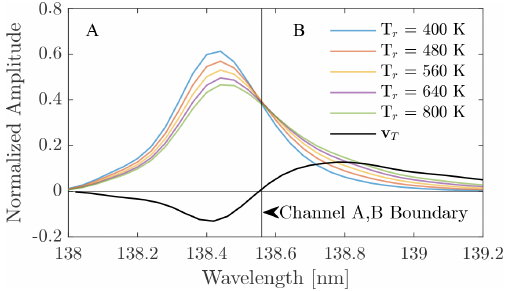
Figure 1. Simulated top-of-atmosphere mean LBH emissions s (gray), I LBH , and the principal components associated with over- all brightening of emissions (dashed black), v B , and the tempera- ture signal (solid black), v T , scaled by their respective eigenvalues, σ B and σ T . These two principal components account for 99.9% of the variability about the mean for the period of 2–8 Novem- ber 2018. The LBH emissions are generated with a spectral pixel size of 0.04nm and a spectral resolution of 0.19nm FWHM.